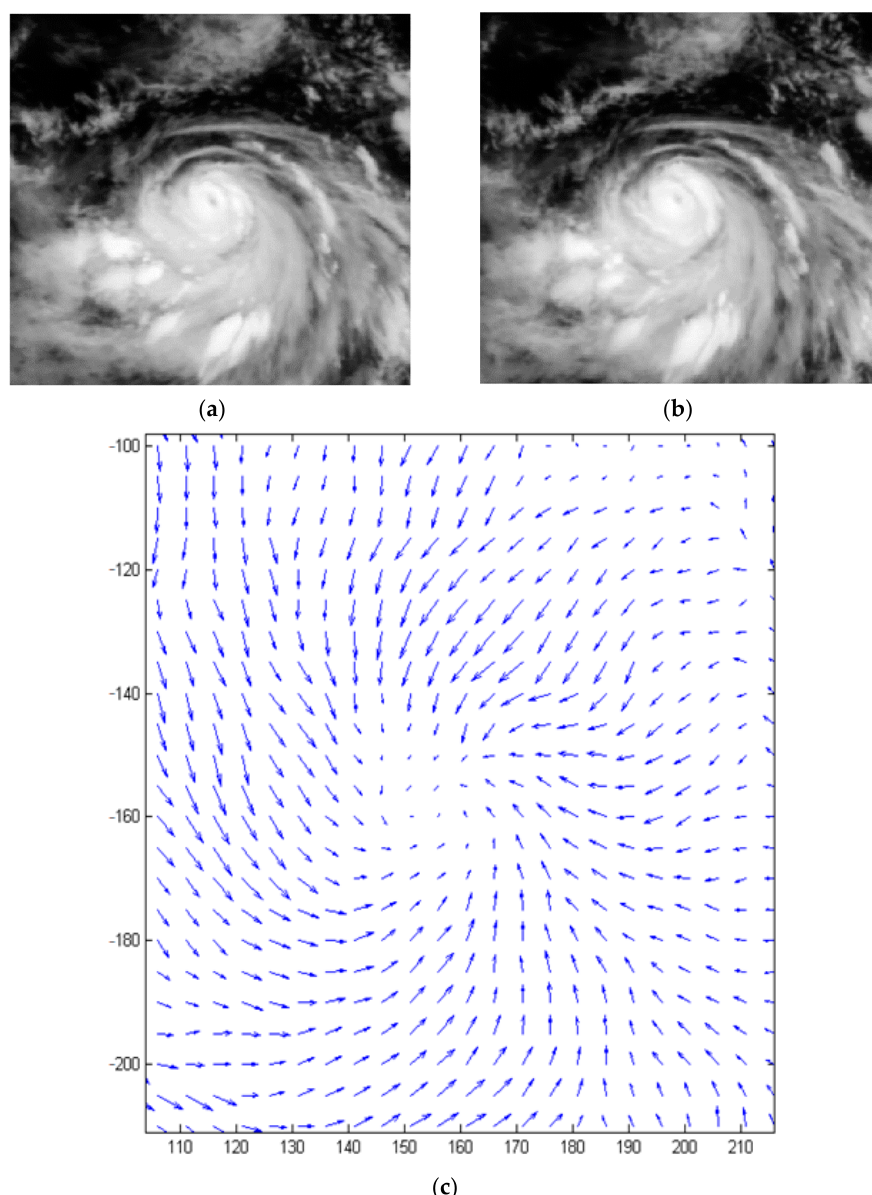
Figure 1. Illustration of the motion field. ( a ) IR image at 1730 UTC on 3 August 2014; ( b ) IR image at 1800 UTC on 3 August 2014; ( c ) motion field calculated using the proposed method.